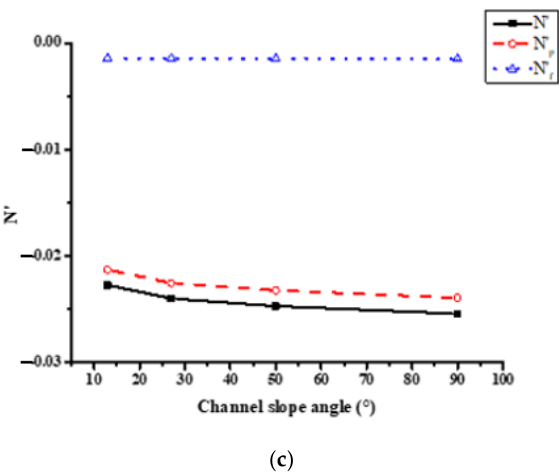
Figure 11. Non–dimensional results of channel slope angle on ship hydrodynamics ( a – c ): resistance force, sway force, yaw moment.